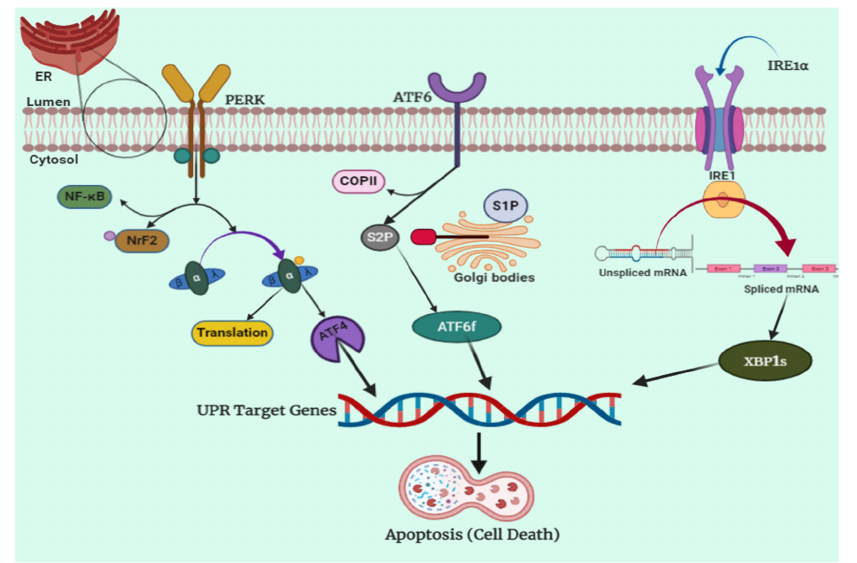
Figure 2. Endoplasmic reticulum stress pathway. The ER stress-associated unfolding protein ac- cumulation stimulates UPR through sensor proteins such asIRE1, ATF-6, and PERK. The ER membrane contains three sensors that detect ER stress: PERK, ATF6, and IRE1. Grp78 dissociates from each of the unfolded proteins that accumulate in the ER lumen, prompting their stimulation. When PERK dimerizes and becomes autophosphorylated, its cytosolic kinase domain is activated, phosphorylating eIF2. Cap-dependent translation of ATF4 is enabled as a result of this suppression of overall protein synthesis. Grp78 dissociation induces ATF6 translocation to the Golgi, where it is translated by site 1 and site 2 proteases (S1P and S2P) into a functional transcription factor that ac- tivates XBP1 mRNA transcription. Grp78 dissociation from IRE1 causes IRE1 dimerization and autophosphorylation. When IRE1 is activated, its endoribonuclease activity causes un-spliced XBP1 mRNA to be processed, while its kinase site recruits TRAF2 and ASK1, causing JNK to be stimu- lated. 7. Luteolin and Endoplasmic Reticulum Stress Among the vast number of mechanisms of the anticancer activity of luteolin is the cell apoptosis through ER stress and UPR, for which there is substantial amount of evi- dence in the literature. Kim et al. confirmed the induction of ER stress being involved in the cytotoxic effect of luteolin through increasing ROS and Ca 2+ in mitochondria. The florescence microscopy showed very high intensity of the ER tracker dye in cells treated with luteolin, contrary to the control cells. The decrease in the cell proliferation was also revealed by the colony-forming assay, where it was found that the apoptotic bodies’ formation was increased in luteolin-treated cells as compared to the untreated control cells. The expression of the proteins associated with the ER stress and also the reactive oxygen species levels were elevated in the melanoma cells after treatment with luteolin. Another very important assay, the Western blotting assay, was used to estimate the pro- teins associated with ER stress, and proteins such asATF6, eIF2 α , cleaved caspase 12, PERK, and CHOP were found to be present in higher proportions in luteolin-treated cells [143]. Another study was conducted by Park et al. on lung carcinoma cells to elucidate the mechanism of anticancer activity of luteolin. According to these authors, the luteo- lin-induced cell death occurs through ER stress and non-canonical autophagy, as evalu- ated in NCI-H460 cells. Assays such as flow cytometry, DNA fragmentation assay, Western blotting, etc., were used to for DNA and various ER proteins. The chromatin